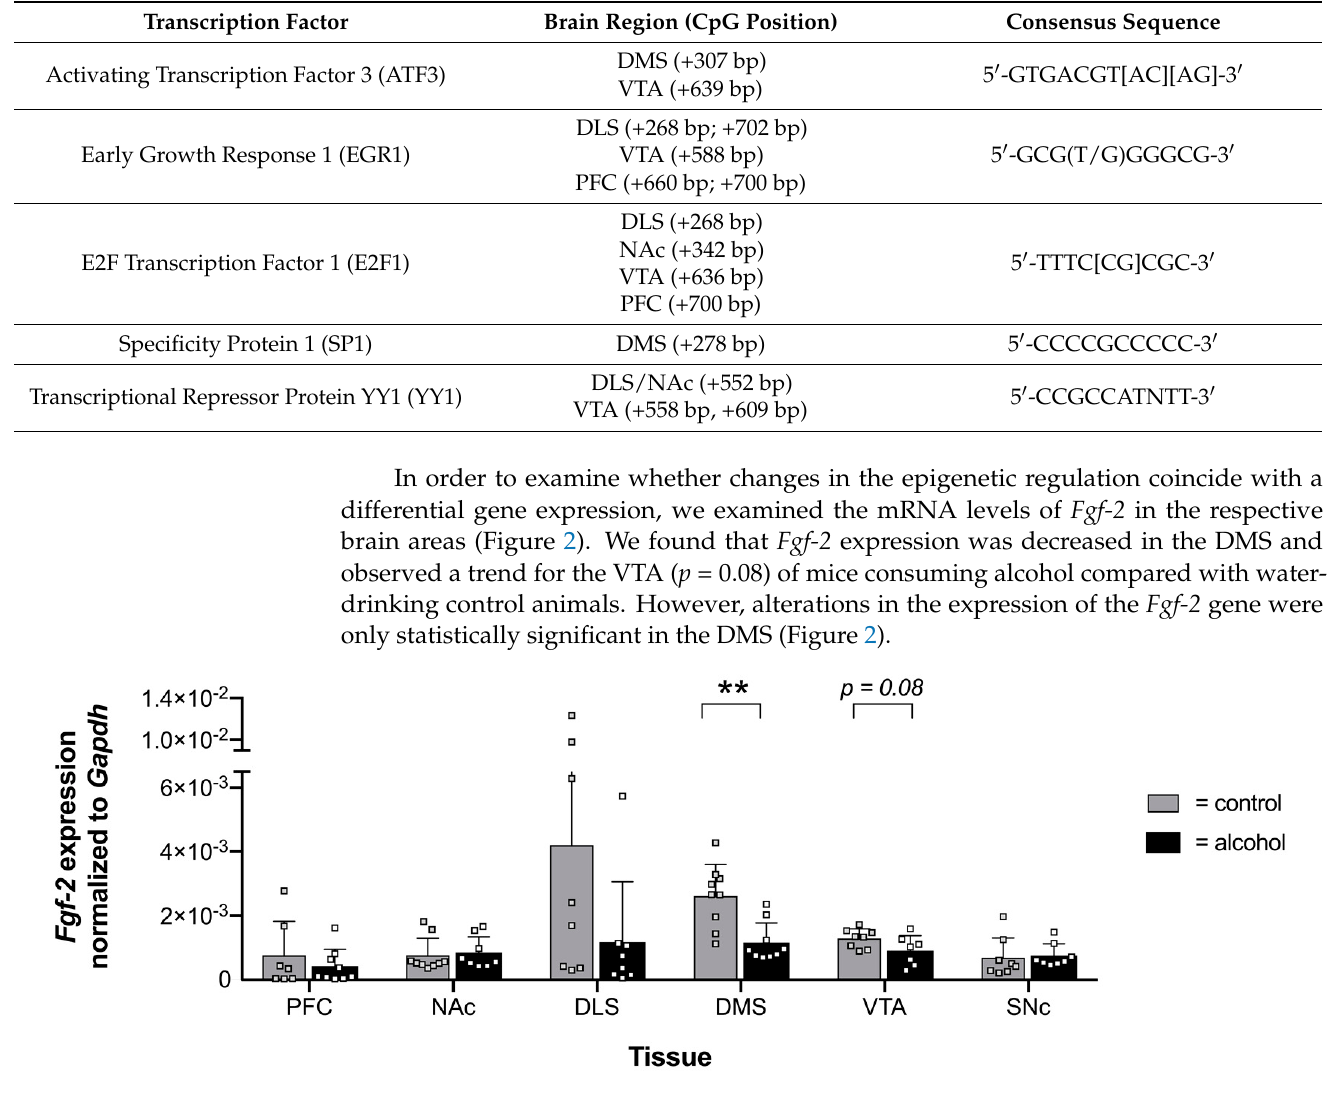
Figure 2. Expression and unified analysis of Fgf-2 . Expression profiles of the Fgf-2 gene within six murine brain areas. Fgf-2 expression was significantly decreased in the dorsomedial striatum (DMS) of mice consuming 20% alcohol for a six-week period compared with the control mice. Data are presented as mean ± SEM with squares depicted as individual data points (n = 7–9 biological replicates) analyzed with Student’s paired t -test, ** p ≤ 0.01 compared with the control group.